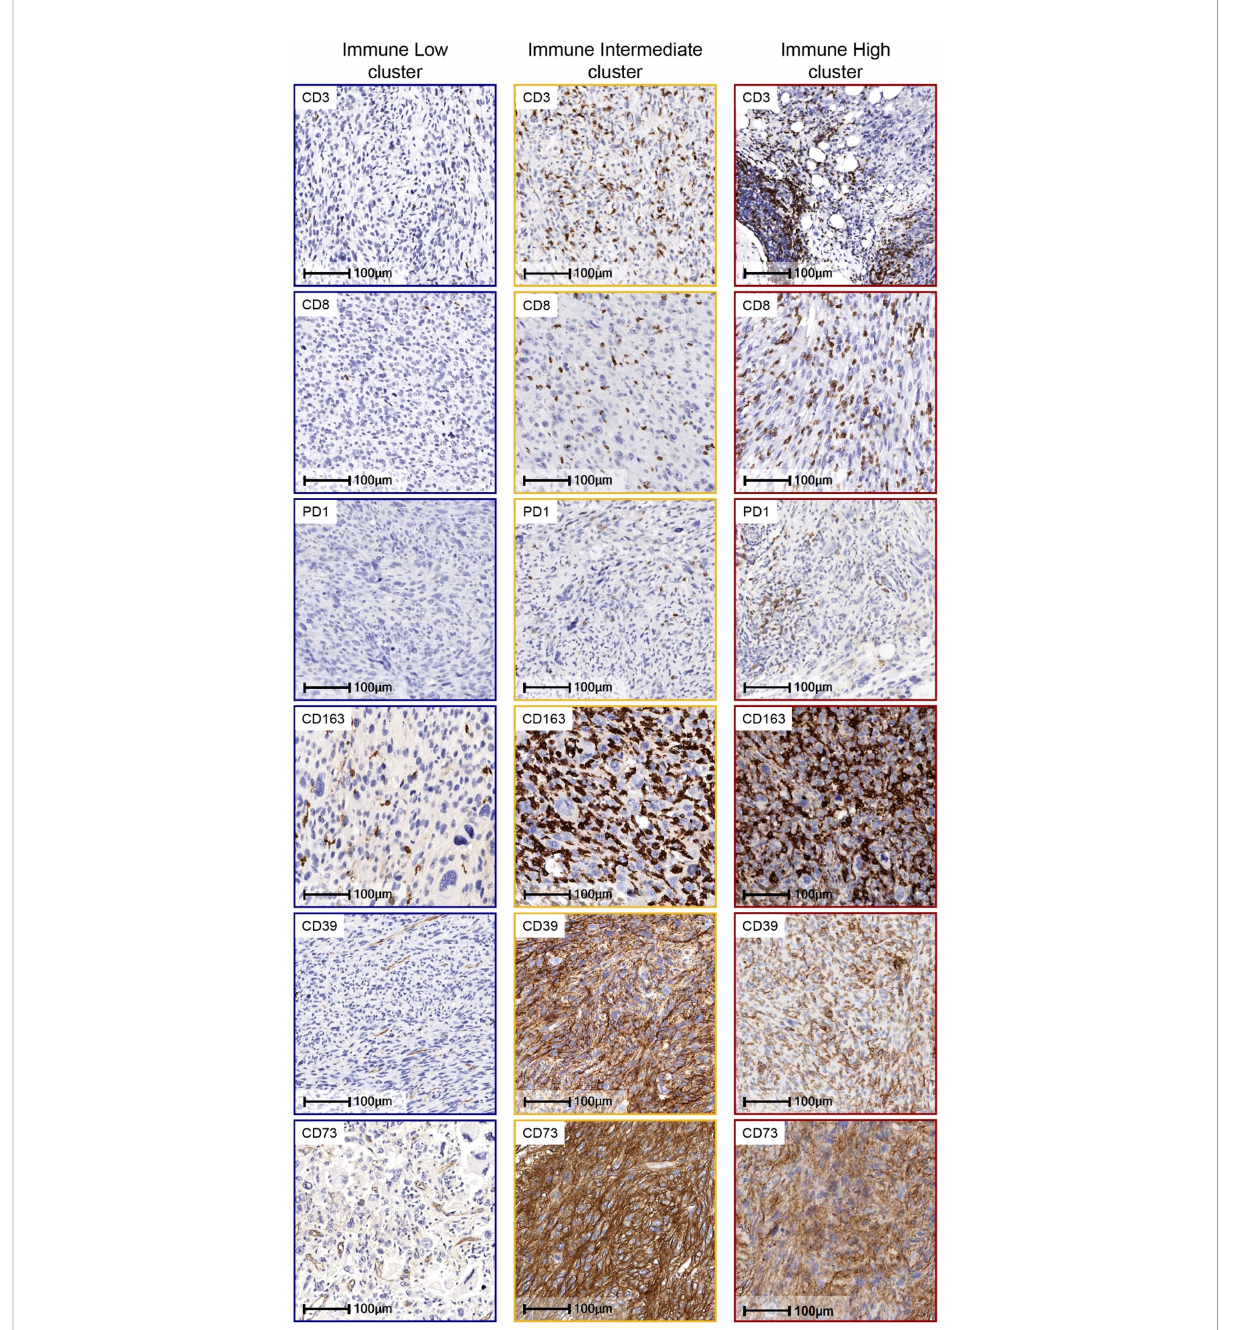
FIGURE 1 Representative Immunohistochemistry (IHC) Images of Tumor-Associated Immune Cells and Immune Checkpoints in UPS by Immune Clusters. On the left in blue square brackets, IHC images of UPS tumors expressing low cell density of CD3, CD8, PD1, CD163, and tumor cells negative for CD39 and CD73, which are characteristic of the Immune Low cluster samples. On the middle column in yellow square brackets IHC images of UPS tumors with moderate density of CD3, CD8 and PD1, and high density of macrophages expressing CD163, and tumor cells positive for CD39 and CD73, which is characteristic of the Immune Intermediate cluster. On the right column in red square brackets, IHC images of UPS tumors with high cell density of all the biomarkers shown, which are representative of the Immune High cluster, IHC images are at 400x magni fi